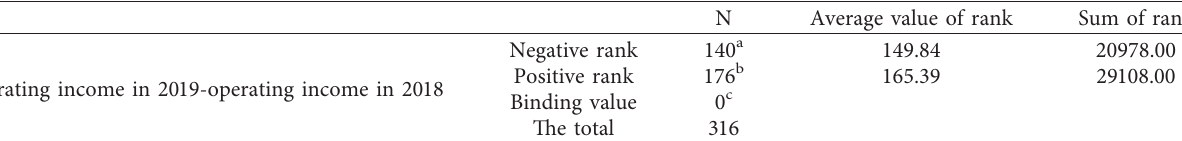
Table 3: Wilcoxon signed ranks test.